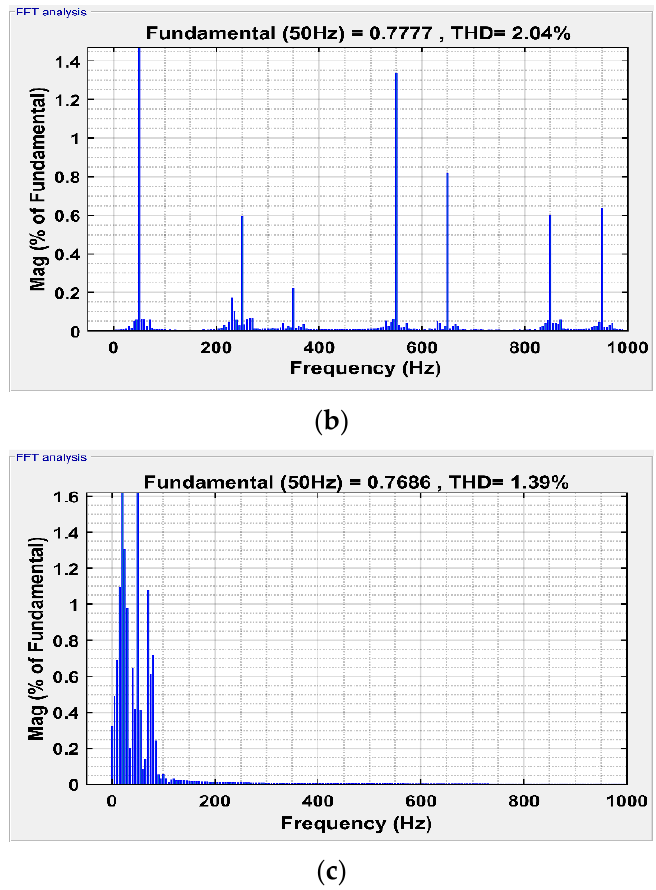
Figure 12. THD performance for case 2 using various filters. ( a ) Passive Power Filter. ( b ) Active Power filter. ( c ) Hybrid Power Filter.